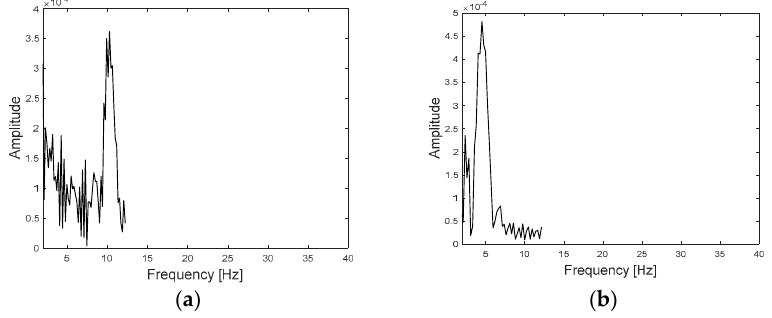
Figure 6. ( a ) Frequency domain for leg-spin balls; ( b ) frequency domain for off-spin